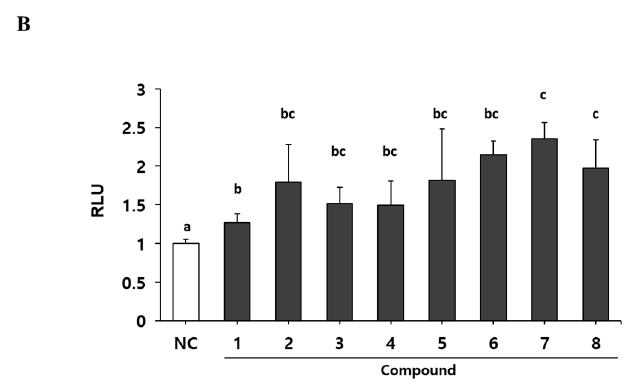
Figure 2. Myogenic effect of compounds 1 – 8 isolated from PC. ( A ) Structures of 1 – 8 . ( B ) Transiently transfected C2C12 cells with a MyoD-responsive reporter gene were differentiated in the presence of each compound (100 nM), followed by measurement of luciferase activity. Data are expressed as mean ± S.D. of three independent experiments. RLU: relative luciferase units. NC: negative control (DMSO) and 1 – 8 : compounds 1 – 8 . Means without a common superscript differ significantly ( p < 0.05).